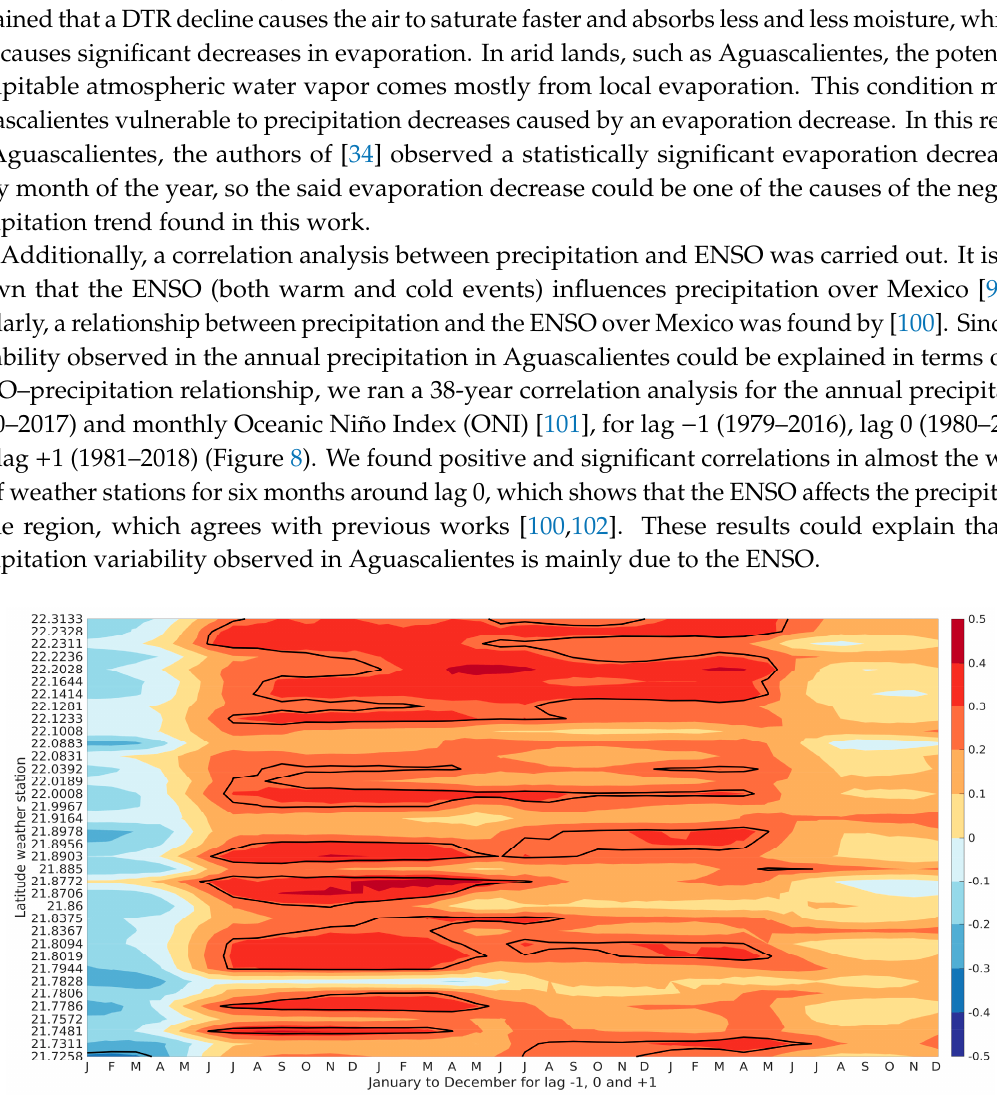
Figure 8. Correlation between annual precipitation and the Oceanic Niño Index (ONI) during 1980–2017 for lag − 1, 0, and + 1. Black contours indicate a significant correlation. The latitude in the Y-axis corresponds to each weather